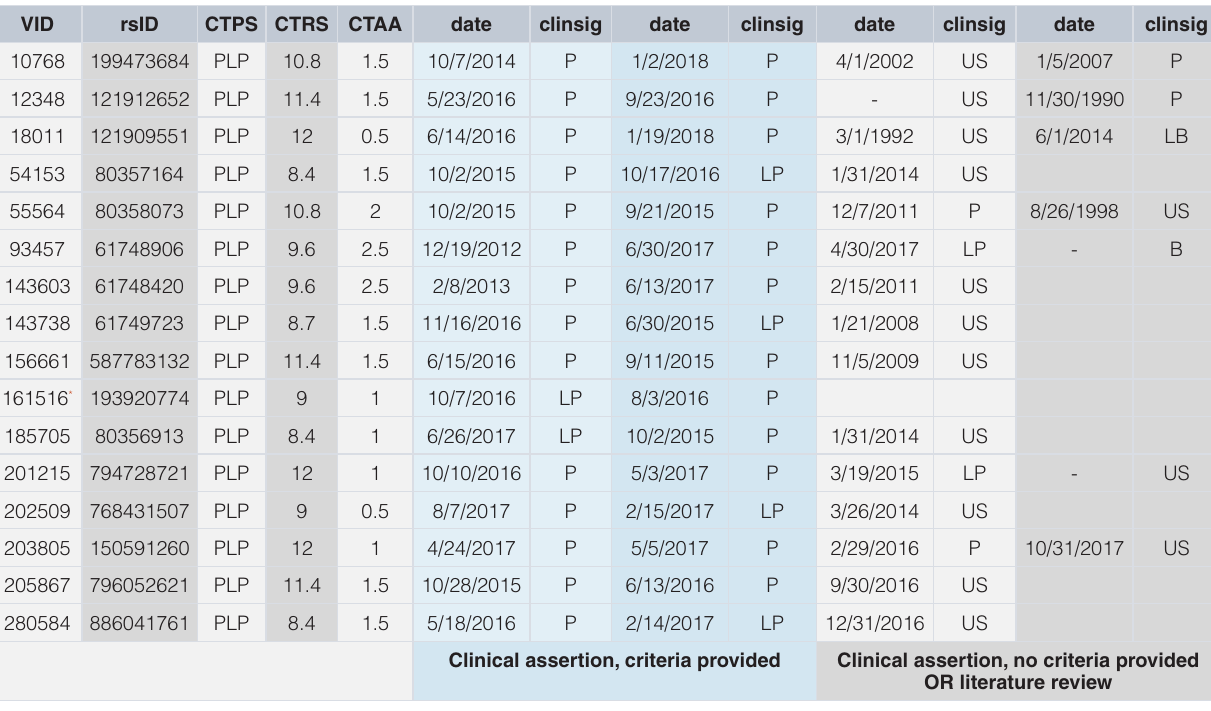
Table 4. Conflicting Interpretation variants with two criteria-driven assertions and a medically significant reclassification recommendation of three. VID, Variation ID; rsID, dbSNP reference SNP ID; CTPS, Clinotator predicted significance; CTRS, Clinotator raw score; CTAA, average clinical assertion age; clinsig, clinical significance of assertion; B, Benign; LB, Likely Benign; US, Uncertain Significance; LP, Likely Pathogenic; P, Pathogenic; PLP, Pathogenic/Likely